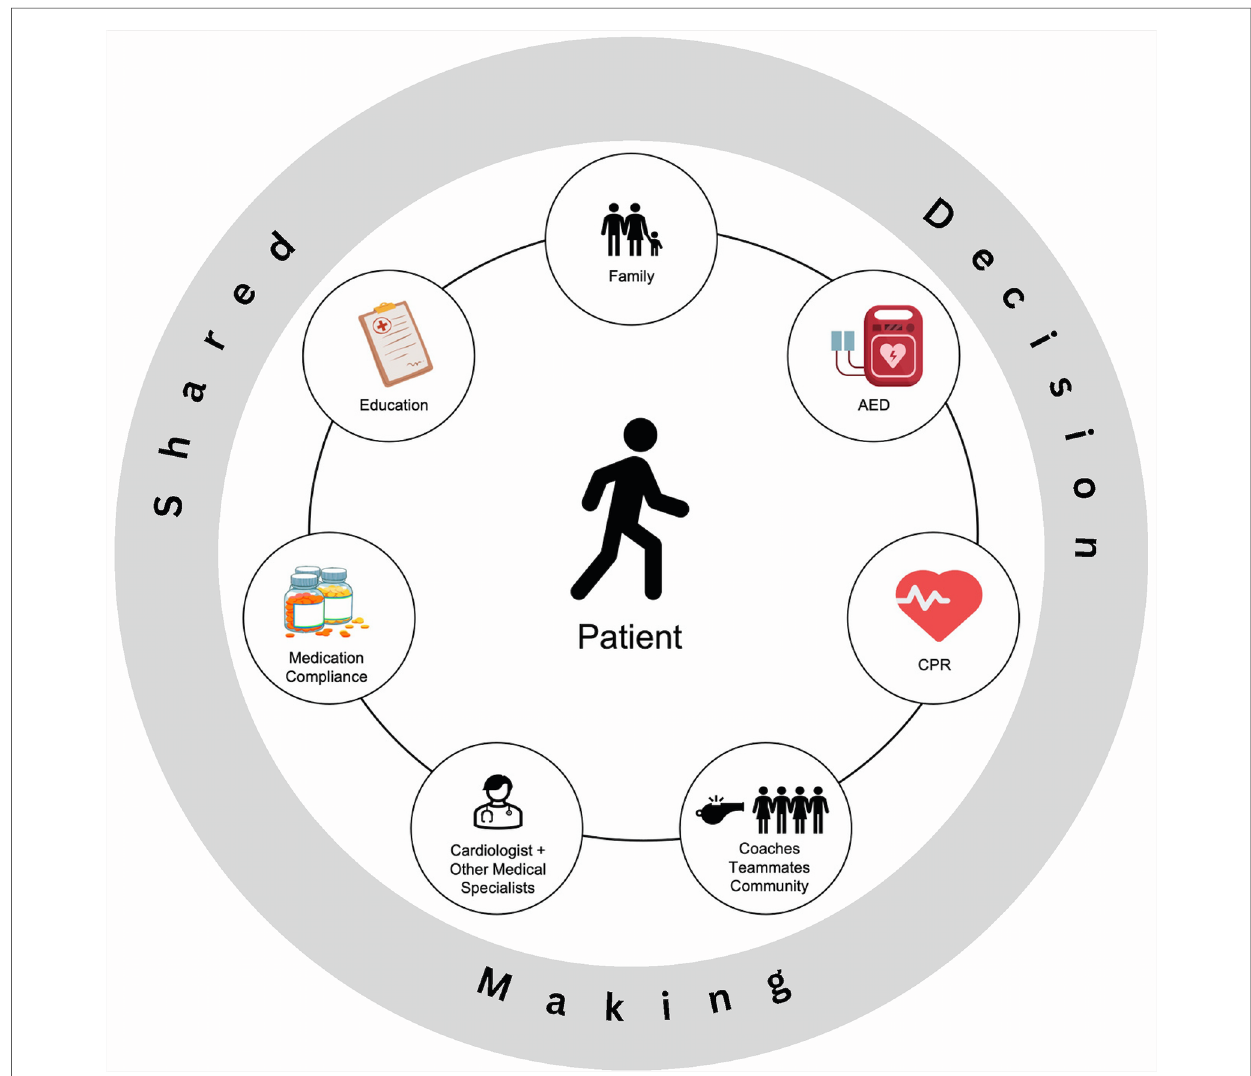
FIGURE 1 Shared decision-making model for sports participation. CPR, cardiopulmonary resuscitation; AED, automated external de fi